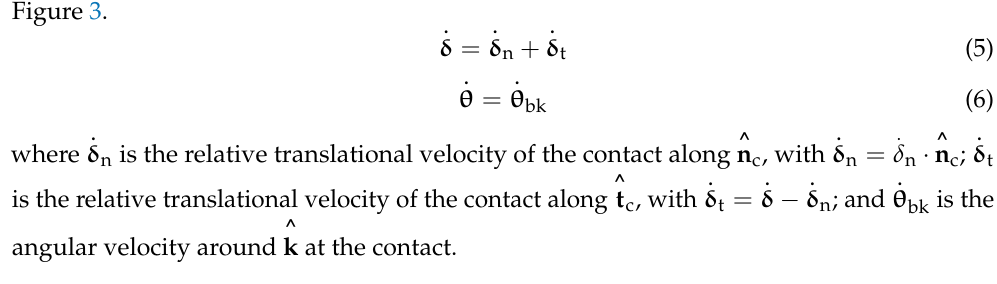
is the angular velocity around